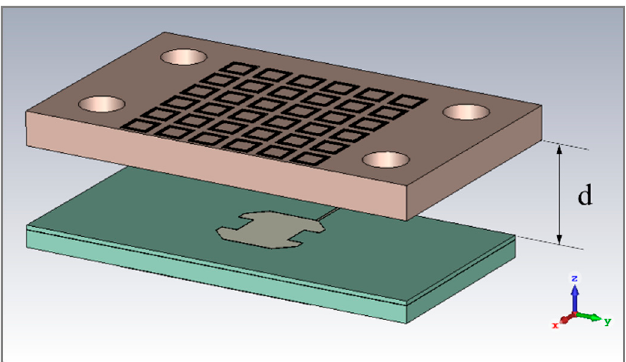
Figure 2. Layout 3D view of the microwave applicator with the split ring resonator-based metamaterial superstrate placed on the substrate integrated waveguide (SIW) cavity-backed patch antenna at a distance d .